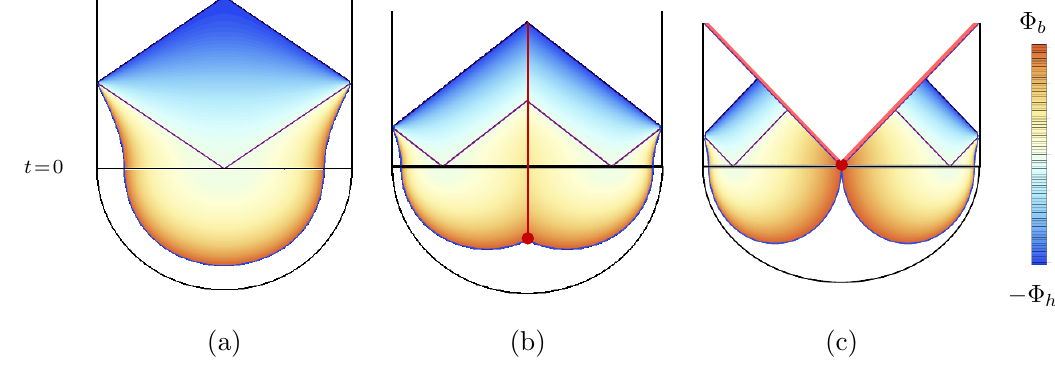
Figure 5 . Dilaton pro(cid:12)le. The values of the dilaton in arbitrary units go from large positive values of (cid:8) at the boundary (red end of color spectrum) to large negative values ending at the inner horizon (blue end of color spectrum): we show ‘ (cid:24) 0 (left), ‘ (cid:24) N=(cid:12)J (middle) and ‘ (cid:24) N (right). (cid:8) is smaller than (cid:8) everywhere inside the cut-o(cid:11) curve and has a local minimum at each b horizon. For the TFD in euclidean space (circle in the Poincare disk) one has concentric circles of constant dilaton. In the continuation to Lorentzian signature across the t = 0 time slice, the boundary curve splits into two hyperbolas (corresponding to the left and right QM) that hit the boundary of AdS after (cid:12)nite global time. Inside of the lorenzian bulk, the 4d singularity is located where (cid:8) + (cid:8) = 0 so one could imagine taking as a 0 cut-o(cid:11) (cid:8) = (cid:0) (cid:8) or to be safe (cid:0) (cid:8) . From the 4d perspective the inner horizon is 0 b